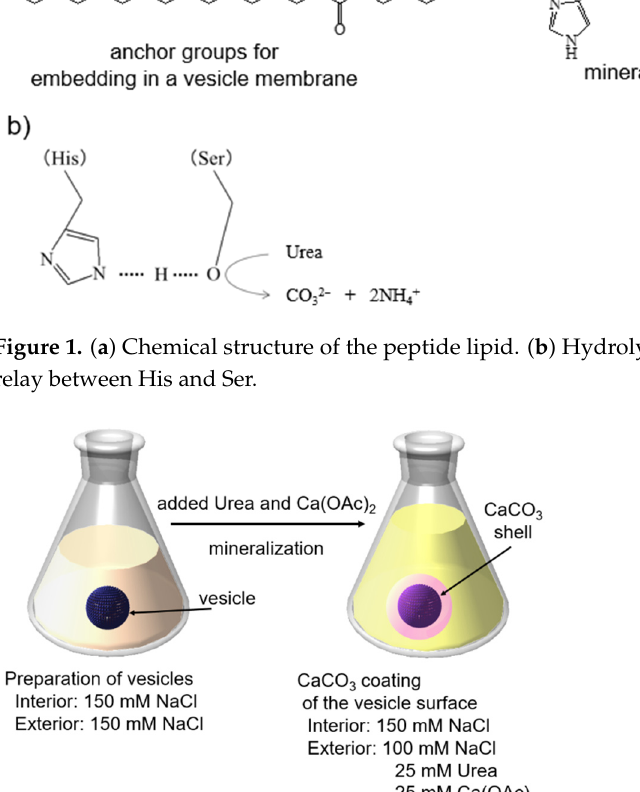
Figure 1. ( a ) Chemical structure of the peptide lipid. ( b ) Hydrolysis mechanism of urea by charge relay between His and Ser.